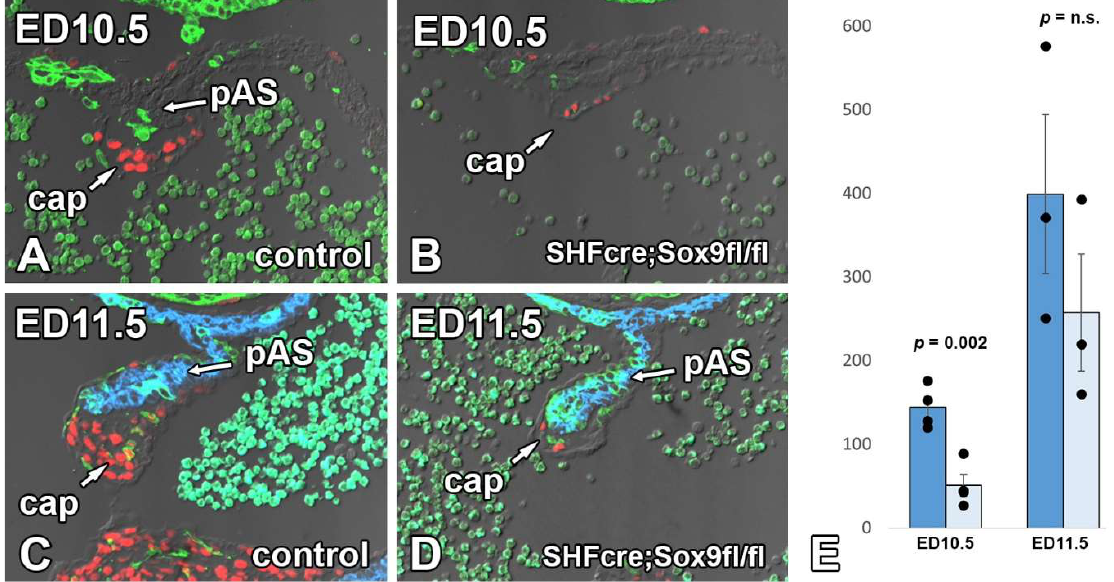
Figure 10. Deletion of Sox9 from the SHF leads to hypoplasia of the mesenchymal cap. Panels ( A , C ) show the mesenchymal cap of control hearts at ED10.5 ( A ) and ED11.5 ( C ) whereas panels ( B , D ) show the cap in corresponding SHFcre;Sox9fl/fl;[R26mG] littermates. The images demonstrate the significant reduction in size of the cap as well as the reduction in number of mesenchymal cells within the cap. The graph in panel E shows the decrease in the number of cells as determined by Cell Profiler Analysis in the controls (dark blue/left) vs. SHFcre;Sox9fl/fl;R26mG hearts (light blue/right). The sections in ( A , B ) are stained for Sox9 (red) and GFP (green), the sections in ( C , D ) for Sox9 (red), GFP (green), and Myosin Heavy Chain (blue). Cap = mesenchymal cap, pAS = primary atrial septum.